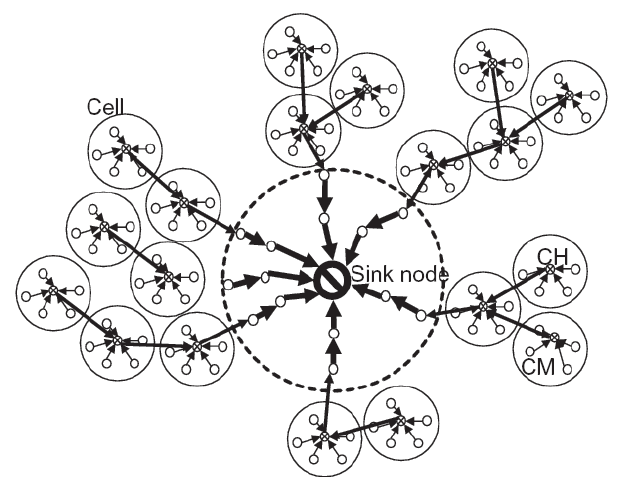
Figure 2. Hotspot area in hybrid routing scheme